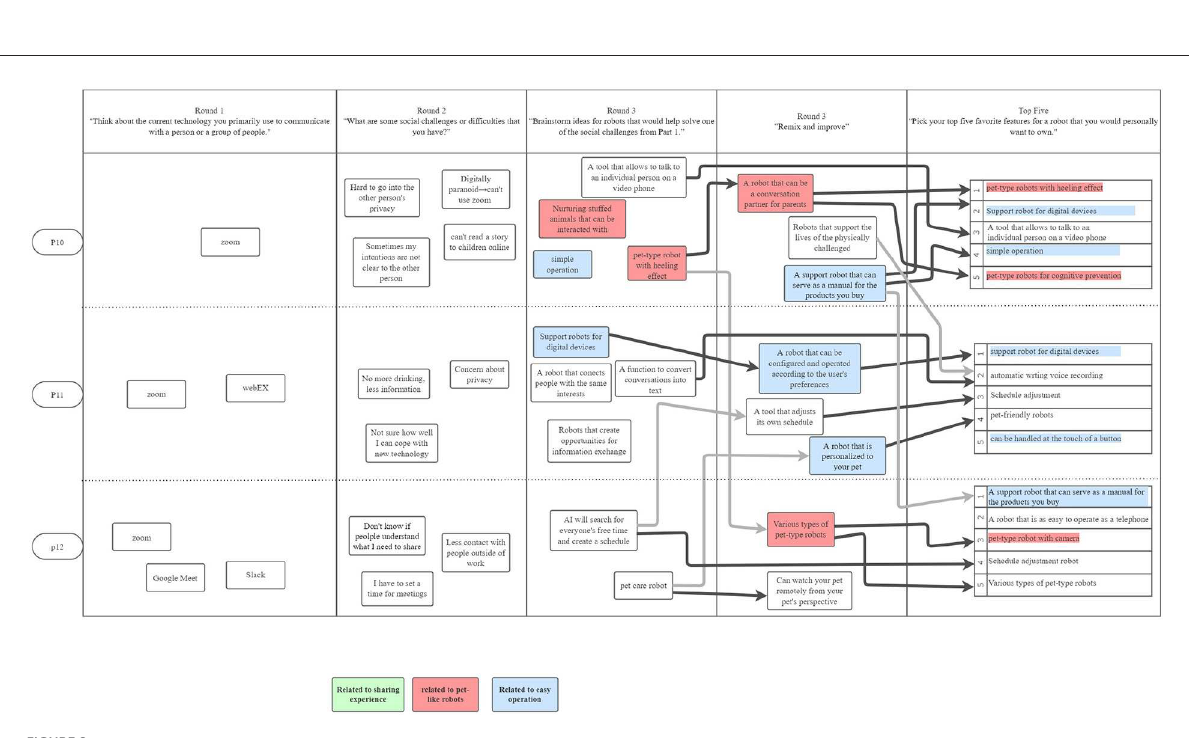
FIGURE8 The fourth PD session in Japan was also held on September 5, 2021 and had 3 participants. P10 and P12 discussed pet-like robots, and P10 and P11 discussed easy operation. All three participants noted the importance of easy operation in their “top